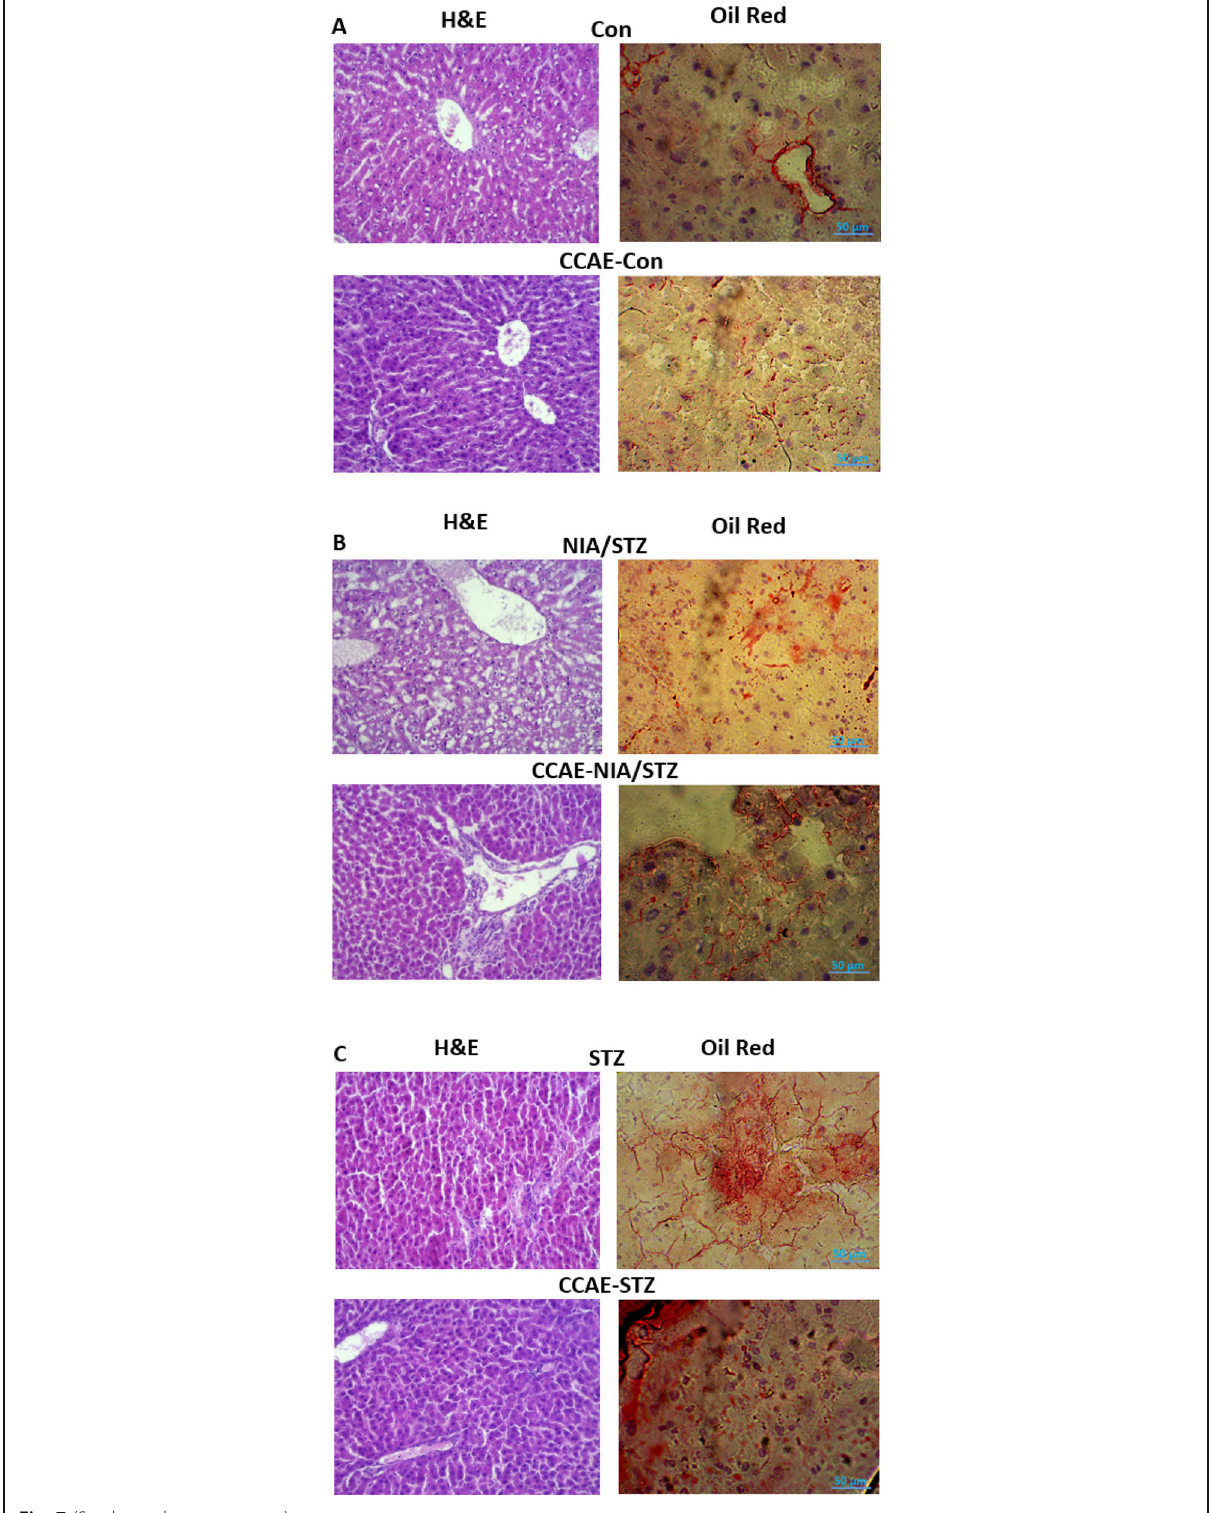
Fig. 7 (See legend on next